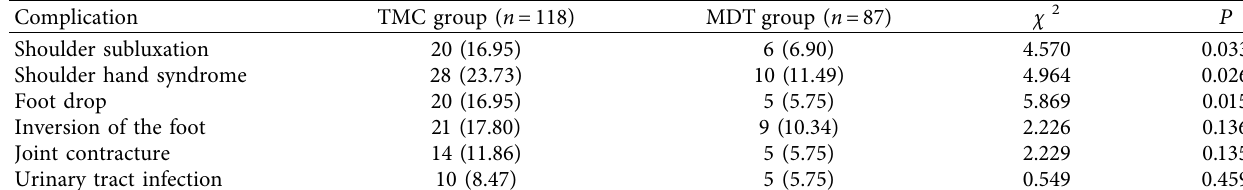
Table 3: Secondary